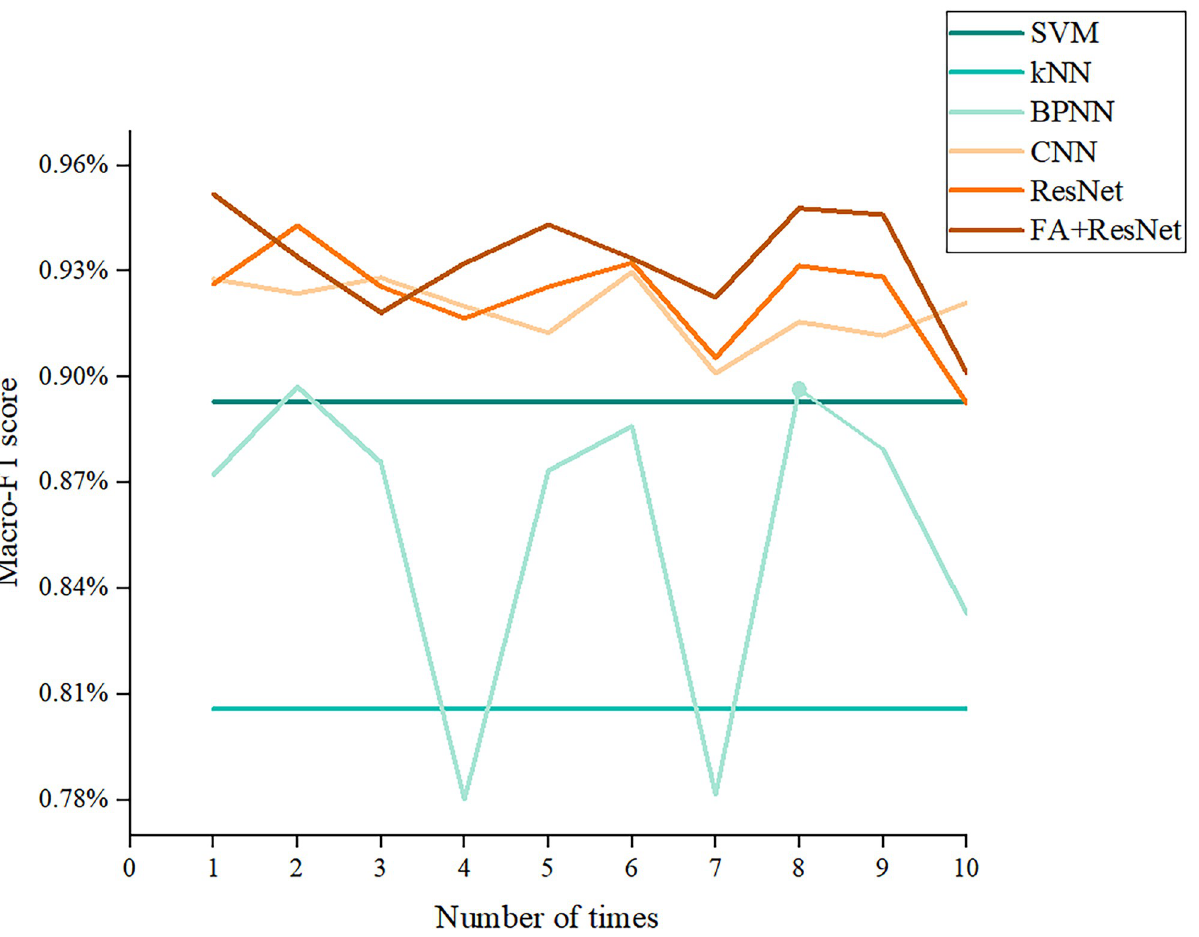
Fig 13. Macro-F1 comparisons of ten experiments with SVM, KNN, BPNN, CNN, ResNet, FA+ResNet models.